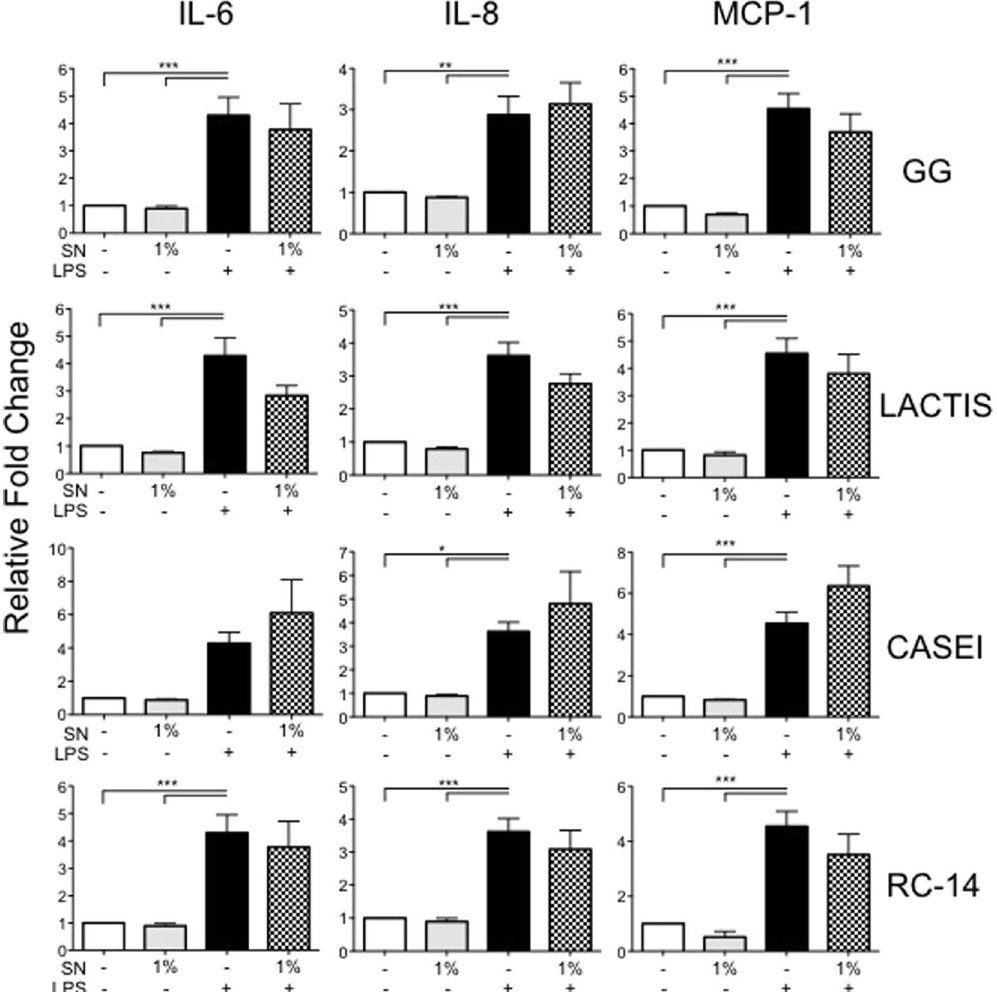
Figure 9. Effect of four different lactobacilli strains on cytokine suppression in hTERT-HM cells stimulated with LPS. Cells were pre-treated with 1% v/v of distinct Lactobacilli species with (checkered) or without (solid) LPS stimulus (100 ng/mL). Results are demonstrated as fold change (mean ± SEM) compared to untreated control (white bars). Statistical significance was determined by One-way ANOVA followed by Dunnett’s post- test compared to LPS stimulus (solid black bars) performed with all doses (1%, 2%, 5%). GG, L rhamnosus GG ; Lactis, L. lactis ; Casei, L. casei ; RC-14, L. reuteri RC-14 . * P < 0.05; ** P < 0.01; *** P < 0.001 (n =